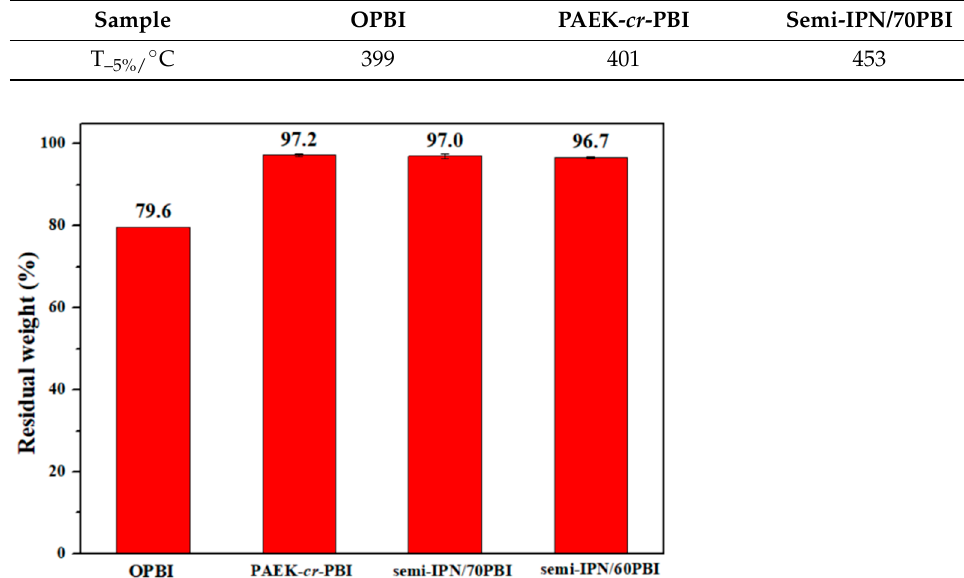
Figure 5. Residual weight of the membranes after treatment with Fenton reagent for 48 h at 80 ◦ C.